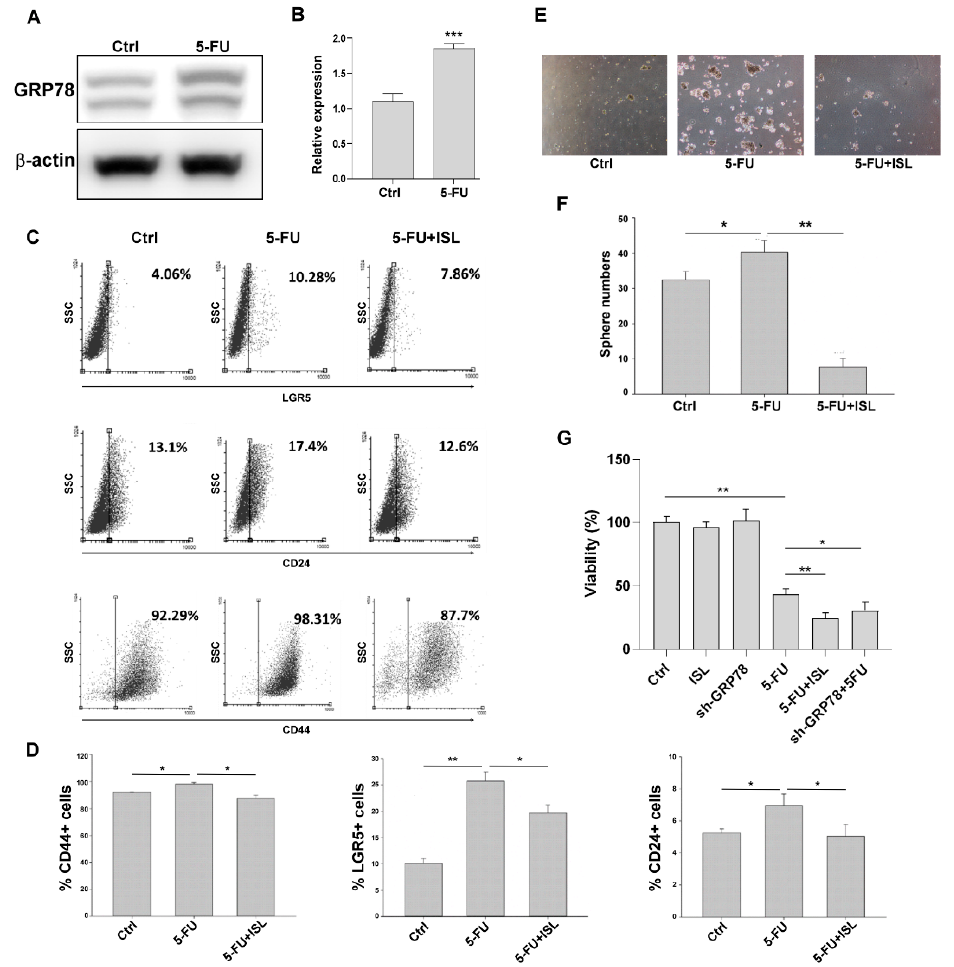
Figure 8. Isoliquiritigenin (ISL) inhibited 5-fluorouracil (5-FU)-induced glucose-regulated protein 78 (GRP78)-mediated stemness. ( A ) GRP78 expression was analyzed through Western blot after treatment with 0.5 μ M 5-FU for 72 h. ( B ) Quantification of GRP78 expression. ( C ) Expression of surface markers (LGR5, CD24, and CD44) was analyzed through flow cytometry in MKN45 cells after treatment with ISL or ISL combined with 5-FU. ( D ) Quantification of surface makers. ( E , F ) Representative pictures showing the spheroid-forming capacity of MKN45 cells treated with or without ISL combined with 5-FU. ( G ) The viability of the MKN45, ISL-treated MKN45, MKN45/sh-GRP78, 5-FU-treated MKN45, 5-FU+ISL-treated MKN45, and 5-Fu-treated MKN45/sh-GRP78 cells was evaluated. Data are presented as the mean ± standard error of mean; n ≥ 3 independent experiments, two-tailed Student’s t test: * p < 0.05, ** p < 0.01, *** p < 0.005.